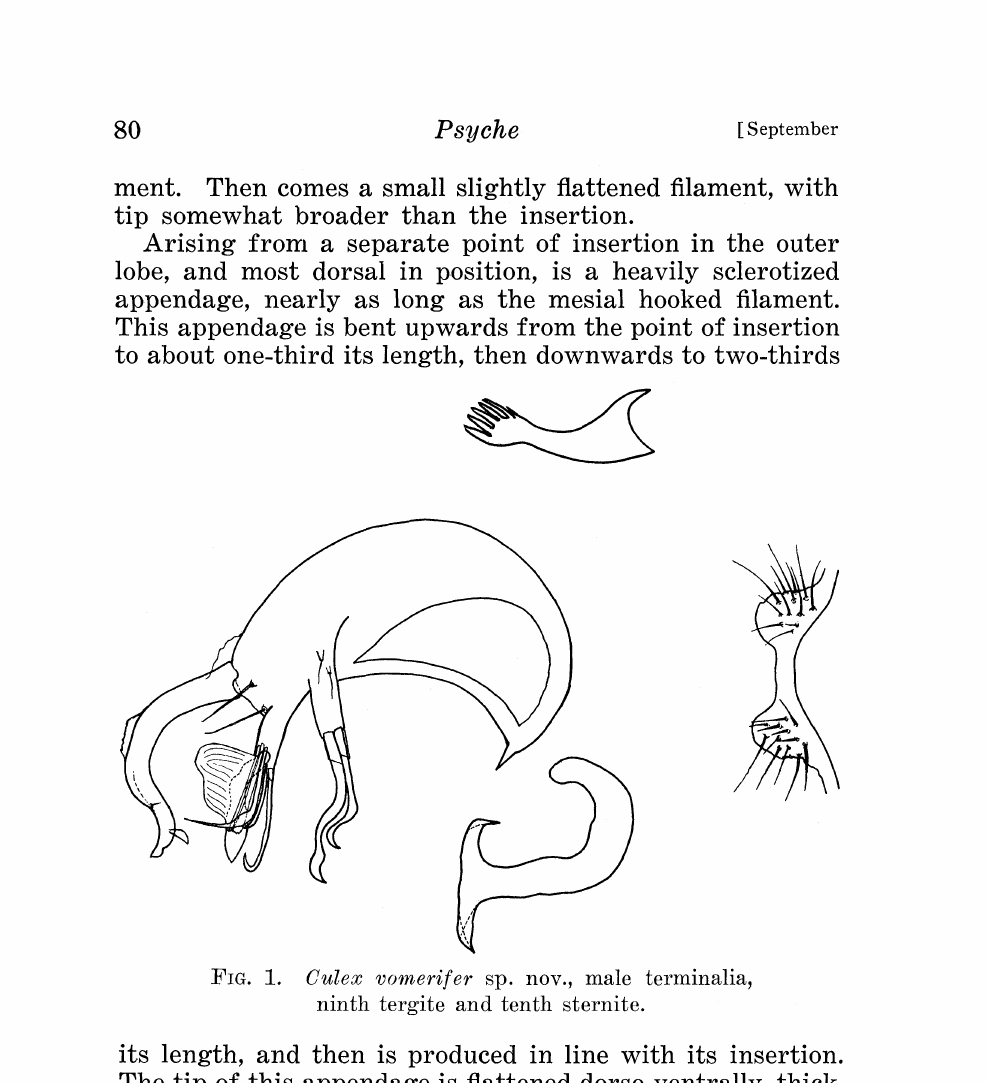
FIG. 1. Culex vomerifer sp. nov., male terminalia, ninth tergite and tenth